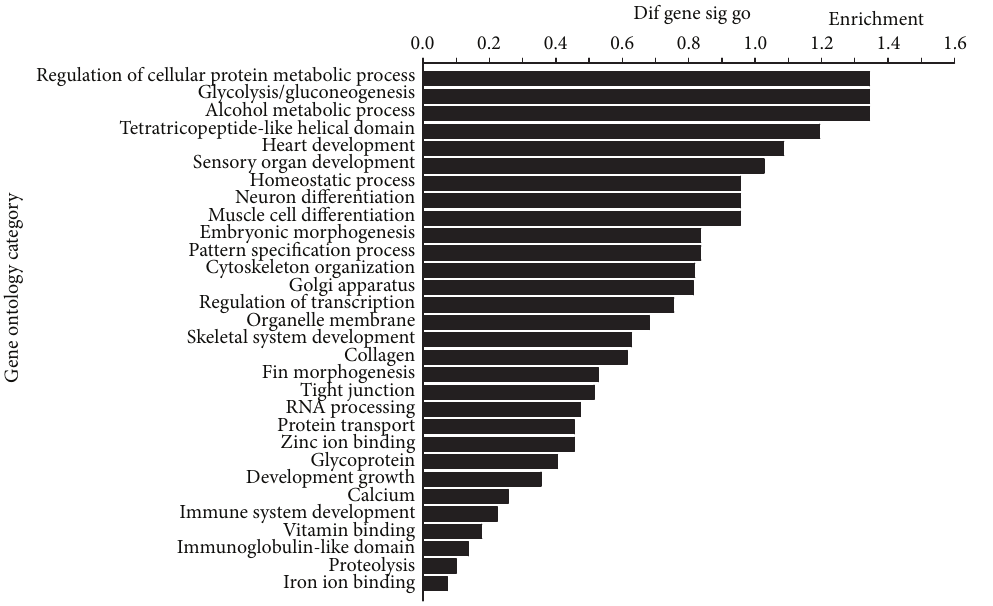
Figure 1: GO category based on biological process for differentially expressed genes. Vertical axis was the GO category and horizontal axis was the enrichment of